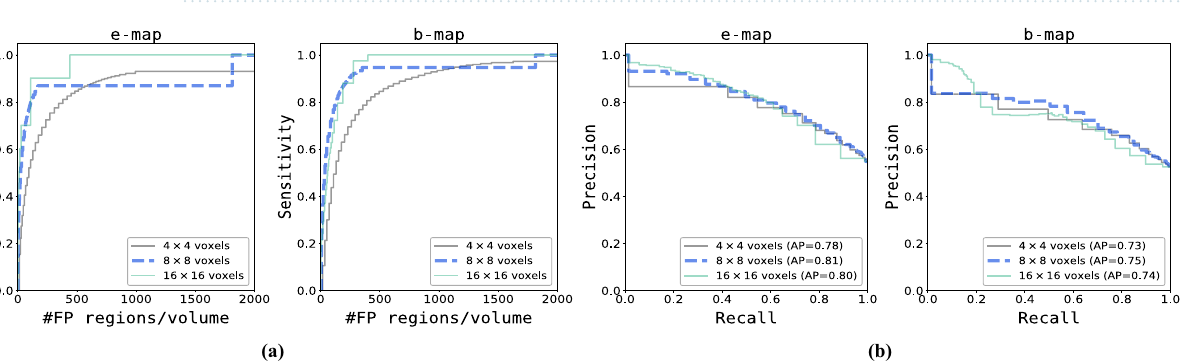
Figure 6. Four patients showing results of combined segmentation and detection approach consisting of segmentation followed by manual expert correction of detected segmentation failures. Expert was only allowed to adjust the automatic segmentations in regions where the detection network predicted segmentation failures (orange contour shown in 2nd column). Automatic segmentations were generated by a U-net trained with the cross-entropy loss. Segmentation failure detection was performed using entropy maps.